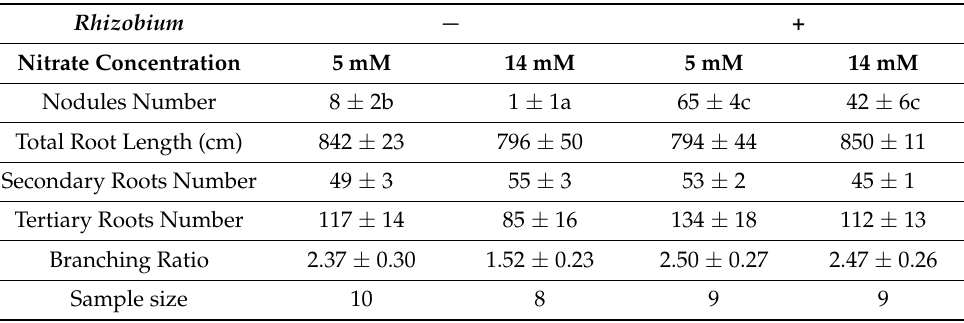
Table 1. Means ( ± SE) of phenotypic traits of pea plants grown in hydroponics with or without Rhizobium and fed nutrient solution with nitrate concentrations of 5 or 14 mM nitrate. Letters (a, b, c) correspond to the significant differences detected by the Tukey test between the experimental conditions for each variable. Rhizobium − + Nitrate Concentration 5 mM 14 mM Nodules Number 8 ± 2b 1 ± 1a 65 ± 4c Total Root Length (cm) 842 ± 23 Secondary Roots Number Tertiary Roots Number 117 ± 14 Branching Ratio Sample